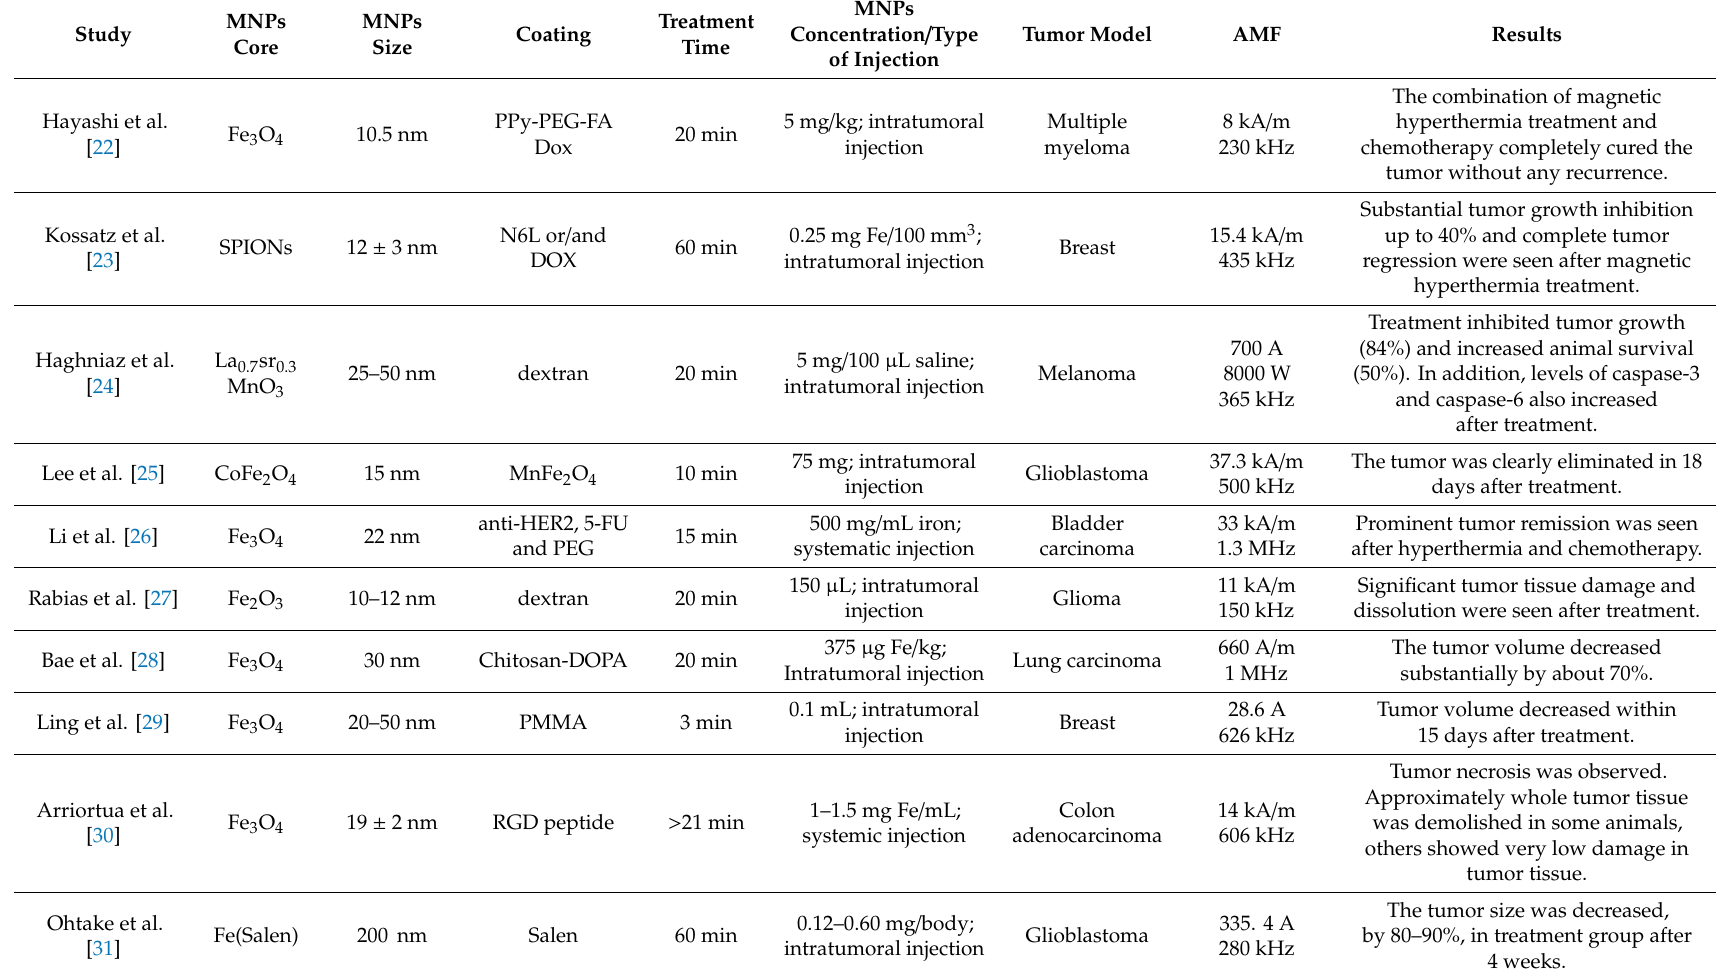
Table 1. Di ff erent types of nanoparticles used in the magnetic hyperthermia treatment for cancer-bearing